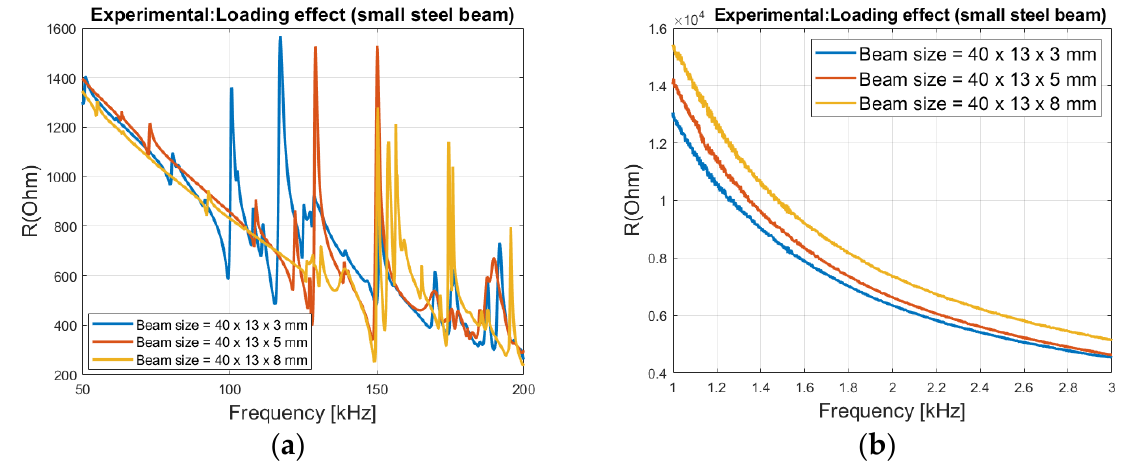
Figure 8. Impact of host structure size on the electrical impedance, ( a ) resonant areas and ( b ) outside resonant areas.